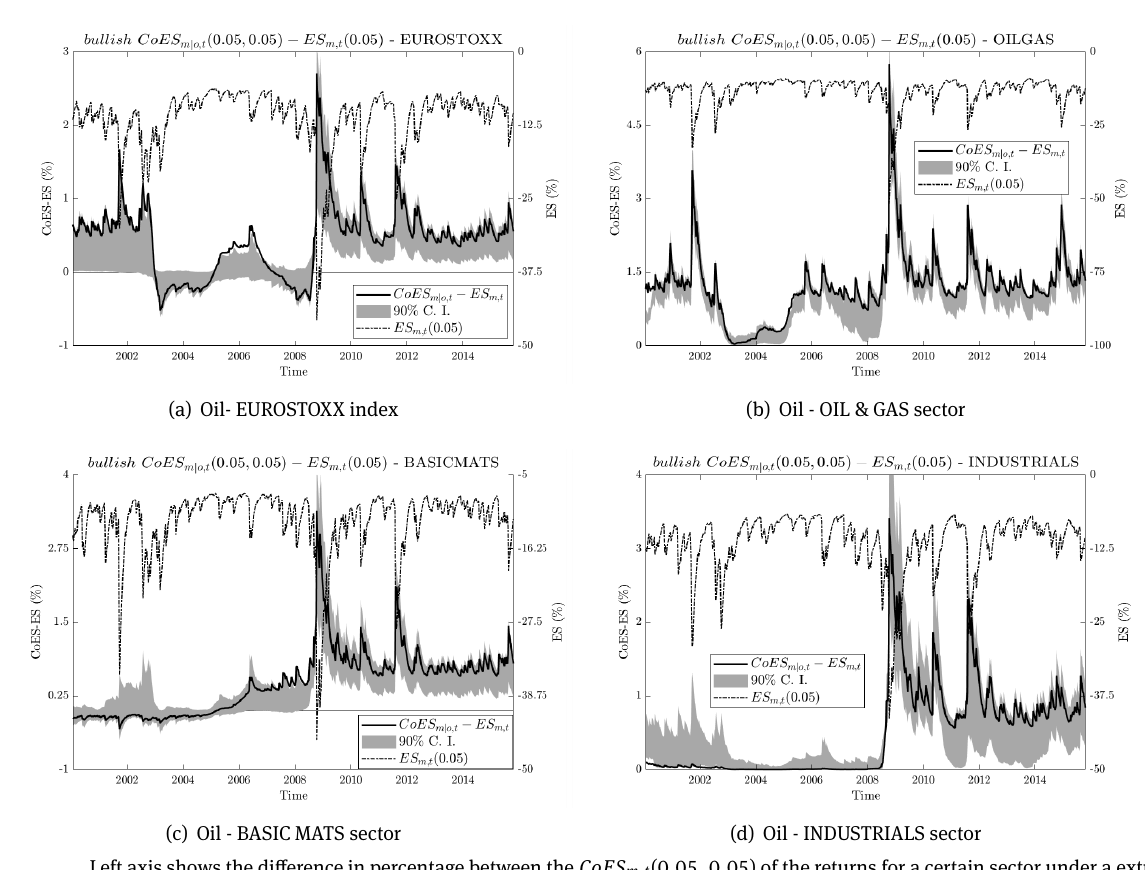
Left axis shows the difference in percentage between the CoES (0.05, 0.05) of the returns for a certain sector under a extreme m , t upward movement in oil prices, i.e. above its 95-th quantile, and its unconditional ES (0.05). Solid blue line shows this m , t difference given the best copula mixture according to Table 6. Grey area indicates the 90% confidence interval of the difference between CoES (0.05, 0.05) and ES (0.05) following a Monte Carlo technique explained in Appendix C. The right axes m , t m | o , t shows the value of the ES (0.05) in percentage. The dash-dotted black line indicate the ES level over m , t